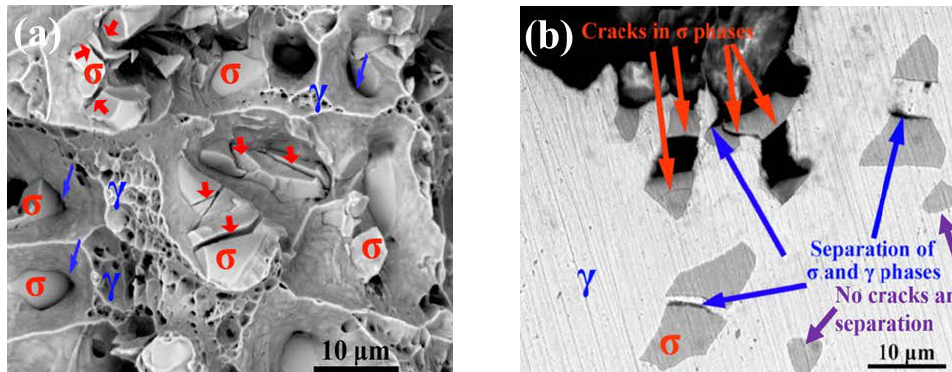
Figure 4. Fracture character of tensile test specimen. ( a ) Fracture surface and ( b ) side of the specimen. The red arrows indicate cracking in the σ -phase and the blue arrows indicate the separation of the interface between the σ -phase and austenitic phase. σ is σ -phase and γ is austenite. It also shows that the cracks only occurred in the σ -phase and the interface of σ / γ . Cracks did not extend into the austenite phase.